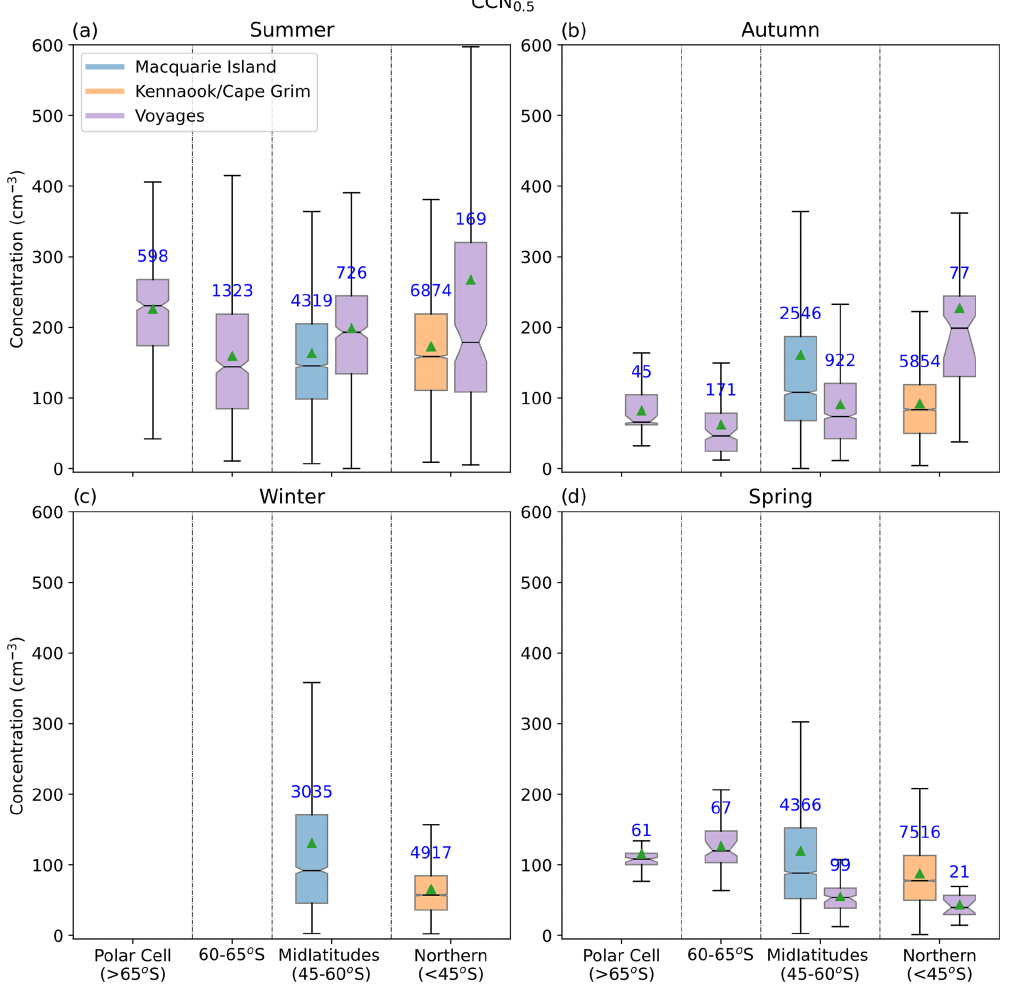
Figure A7. As in Fig. 5 but with y axis limits kept the same across all